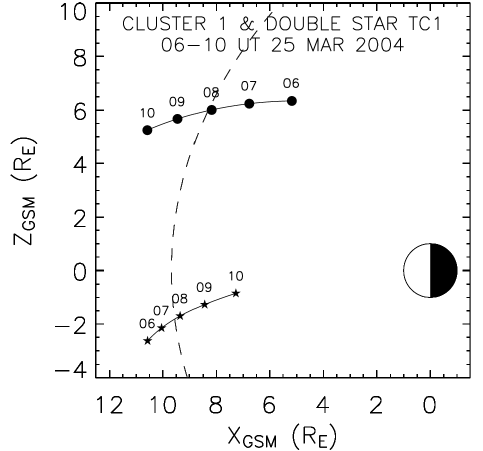
Fig. 1. The locations of the Cluster 1 (circles) and equatorial Dou- ble Star (stars) spacecraft in the noon-midnight meridian during the interval under scrutiny. The location of a Shue et al. (1997) magne- topause is also indicated.